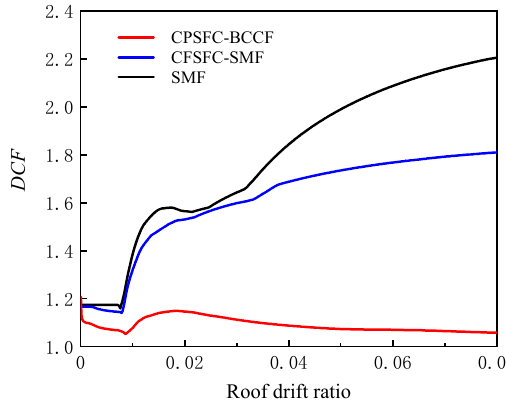
Figure 19. DCF–roof drift ratio curves. Figure 19. DCF –roof drift ratio